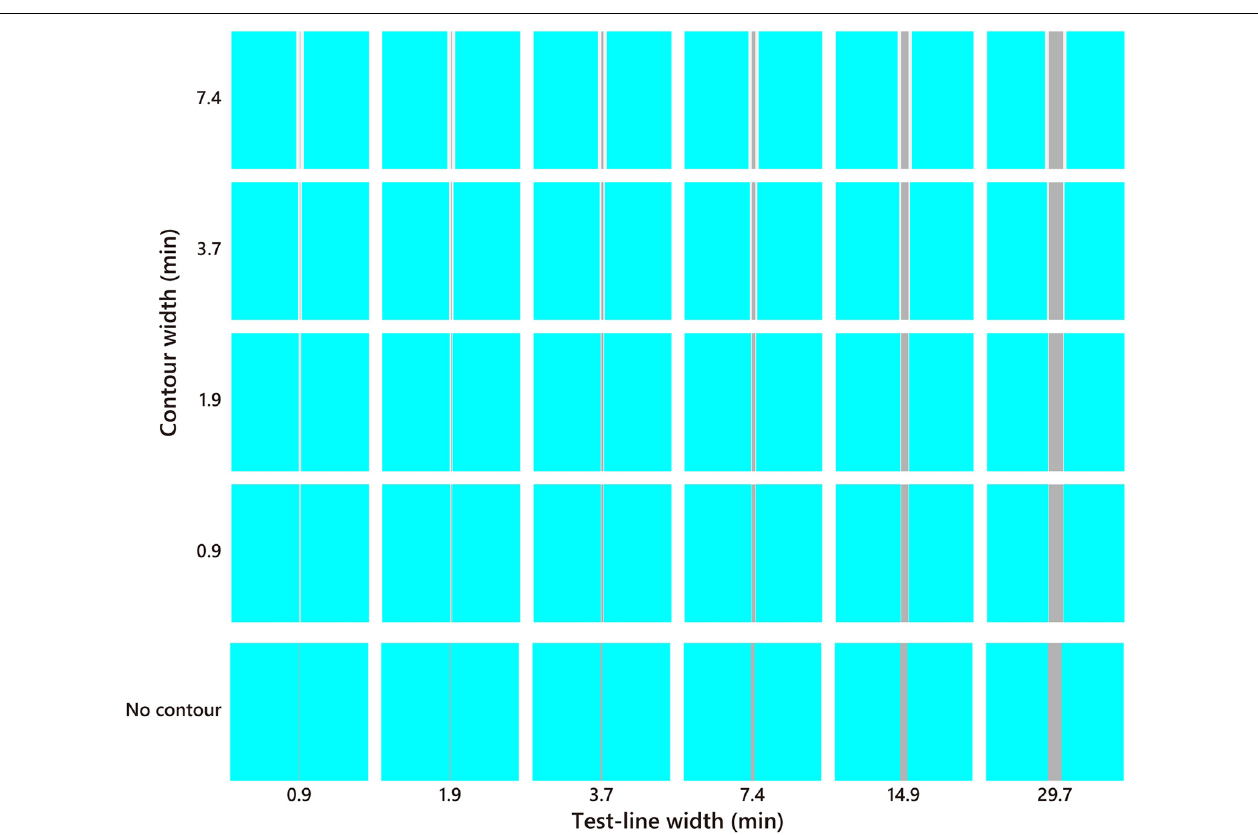
FIGURE 3 | Stimulus example of the cyan inducer. The test line increased in thickness toward the right, and the white contour increased in thickness toward the top. The no-contour condition is shown at the bottom. The color and brightness were optimized for